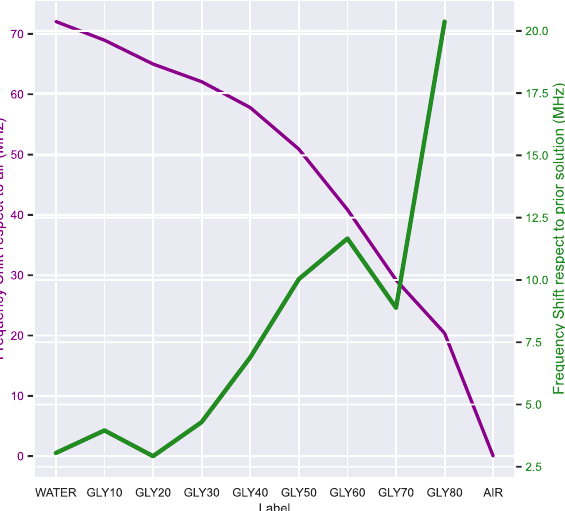
Figure 7. Frequency shift variation with respect to the air reference value (purple) and with respect to the previous glycerin concentration (green). The trend is non-linear since the frequency shift is more significant for values close to air and more uniform for values close to water.